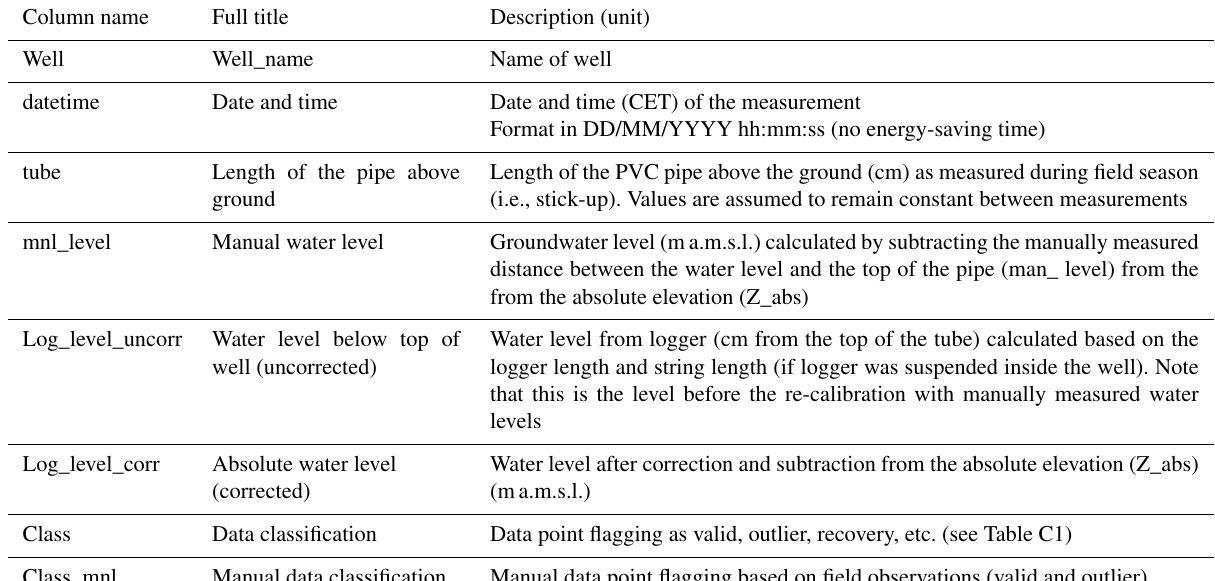
Table B2. Structure of the groundwater-level data file (2022-020_Erdbruegger-et-al_Krycklan_gw_levels.csv) and description of the column